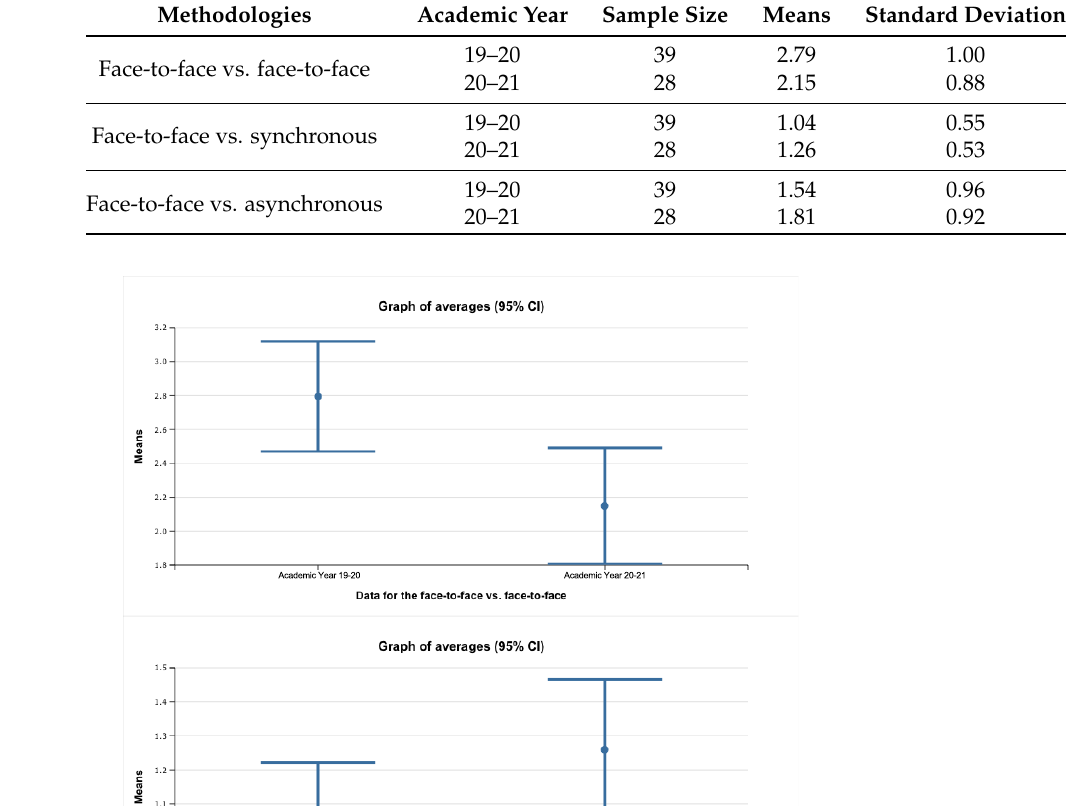
Table 15. Descriptive statistics from the data experiment for different methodologies.